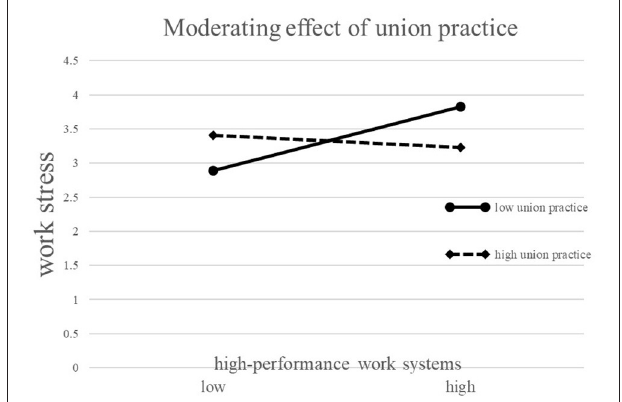
FIGURE 2 | The moderating effect of union practice.